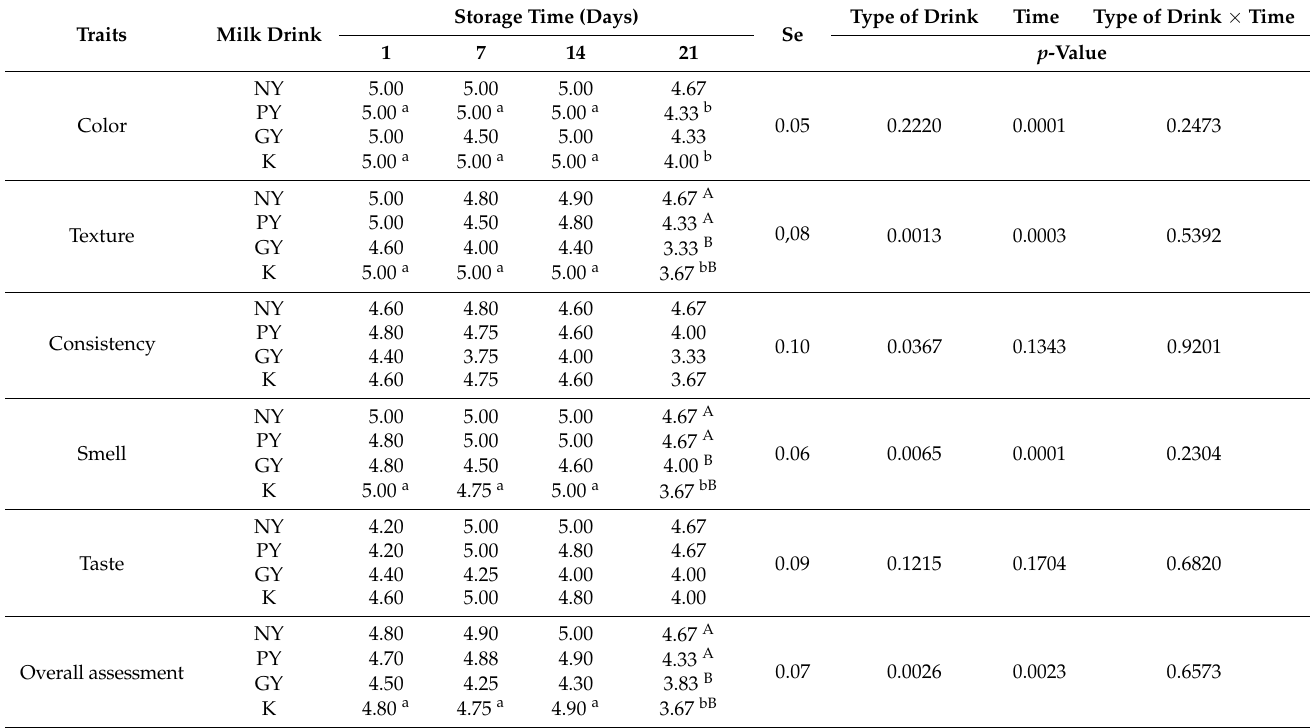
Table 4. The impact of storage time (at 4 ◦ C) and type of drink on selected organoleptic characteristics of fermented milk beverages